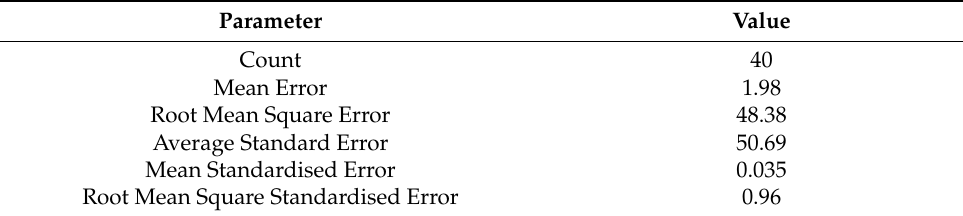
Figure 10. Map of GRP prediction error. Table 4. Discus: Results of executing Cross-validation using Empirical Bayesian